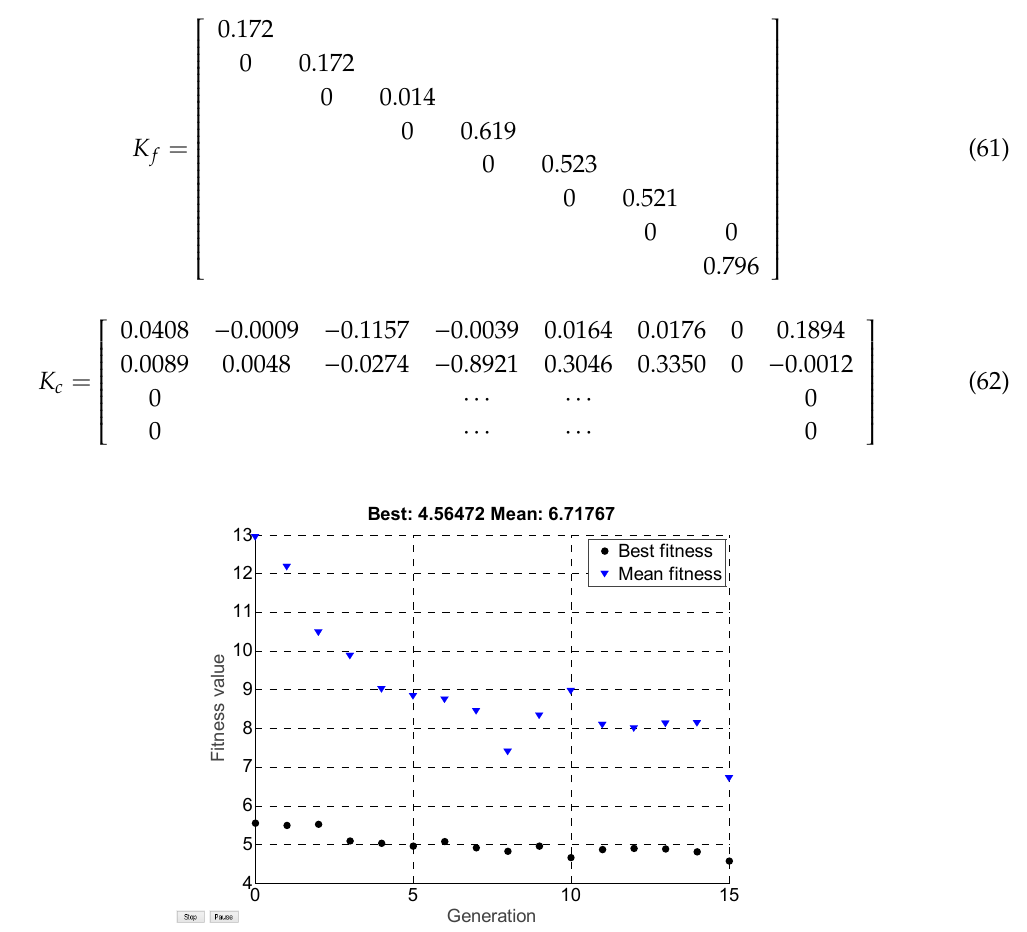
Figure 4. The iterative process of the genetic algorithm. (Note that the best fitness is the minimum value of the cost function in each iteration and the mean fitness is the mean value of the 100 Monte Carlo simulations in each iteration). Table 1. The stability and indicators.